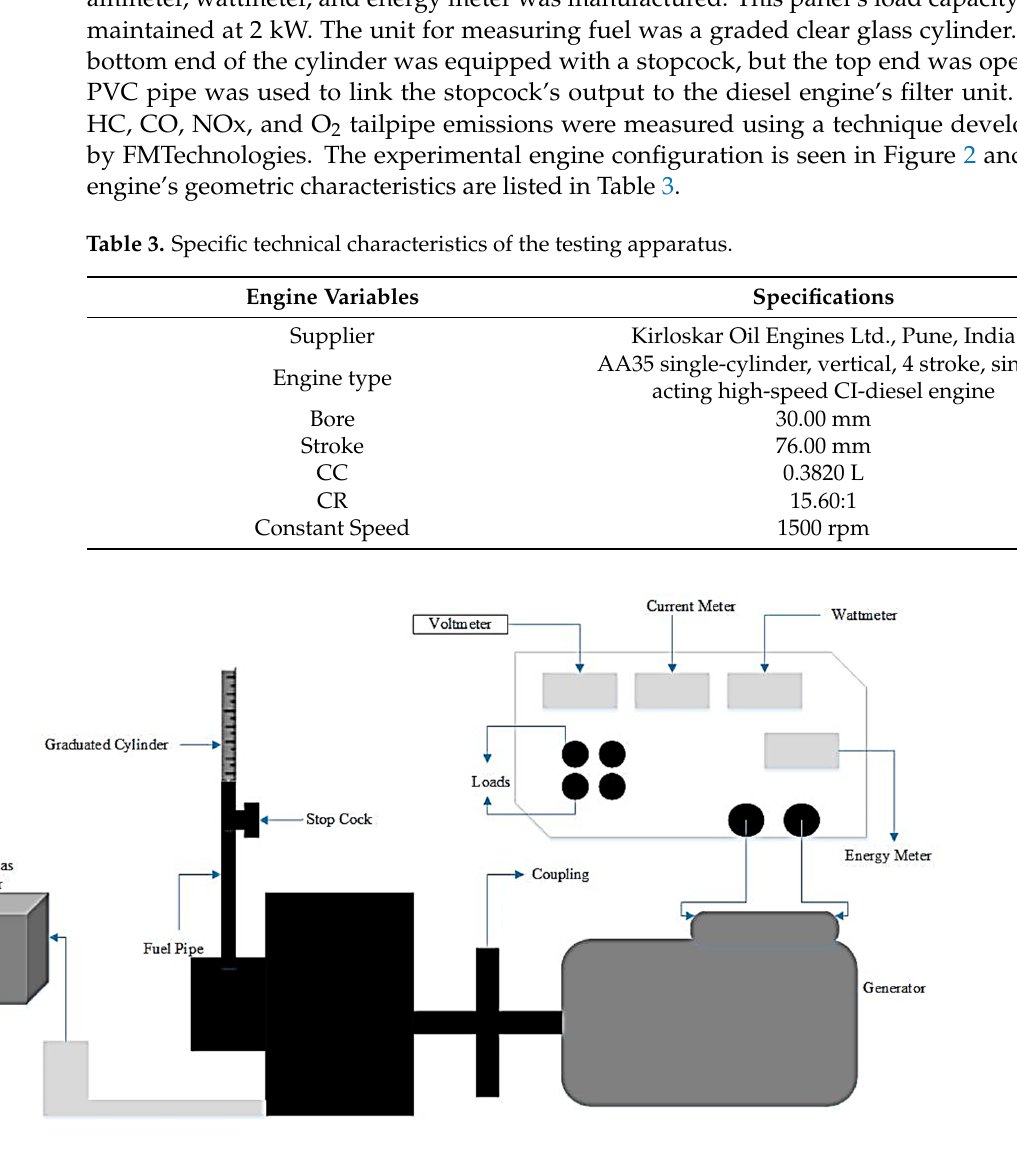
Figure 2. Schematic of the testing setup.